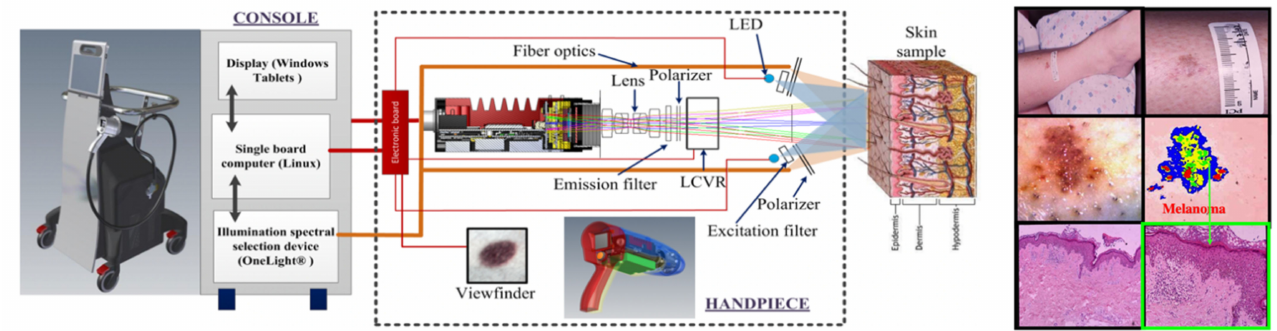
Figure 23. Multimode imaging dermoscope (SkinSpect) ( Left ) and some early melanoma detection results ( Right